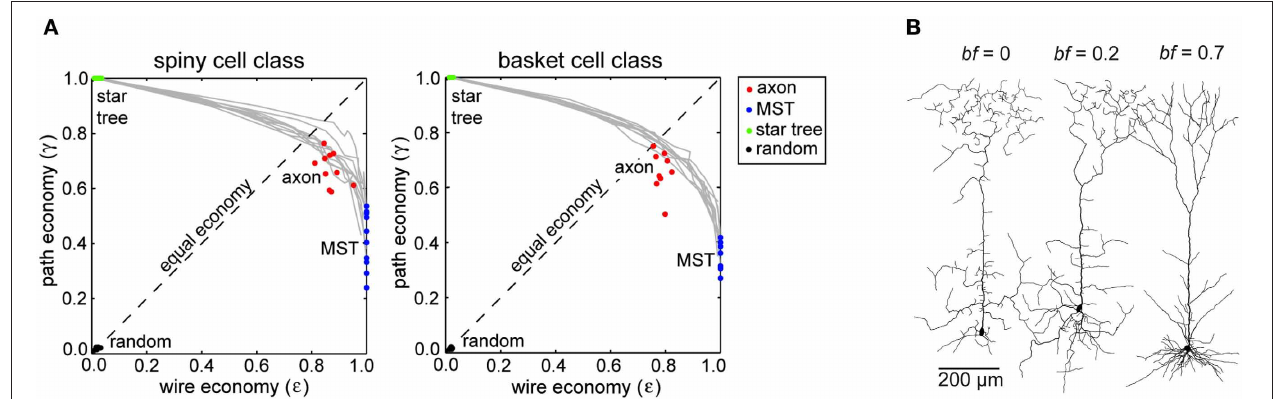
FIGURE 4 | Communication cost trade-off at Neuron scale of cortical organization. (A) Similar degree of trade-off between path length and wire length economy of intracortical spiny (left) and basket cell axon arbors (right) between corresponding path length optimized star trees and wire length optimized minimal spanning trees (MST), which were all more economical